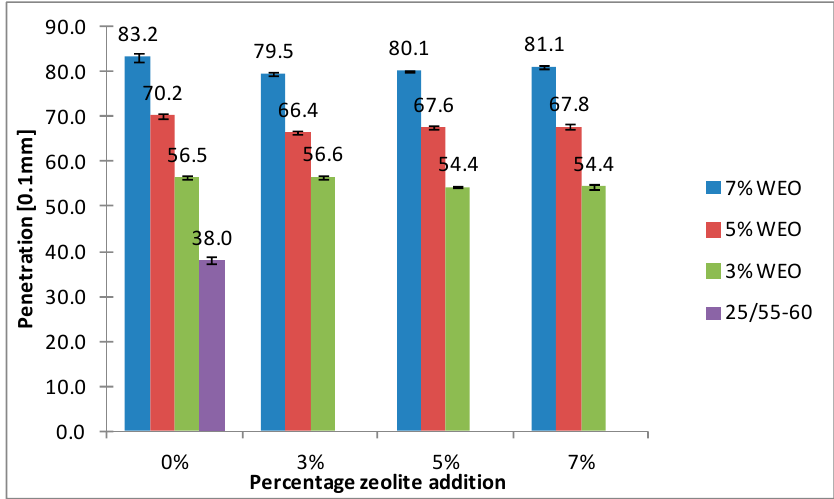
Figure 15. The results of penetration tests for the 25/55-60 asphalt with the addition of WEO and clinoptilolite zeolite measured at 25 °C.